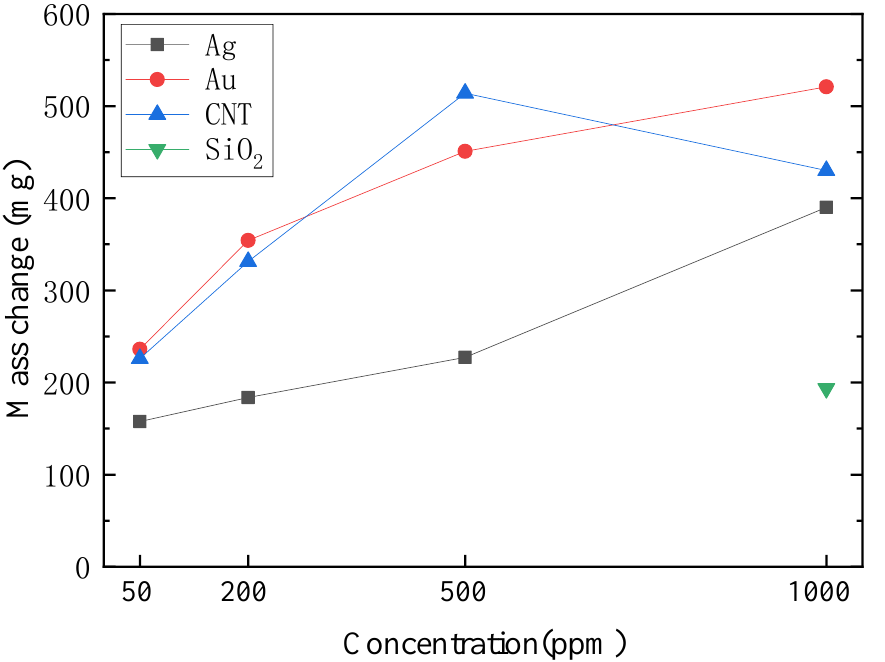
Figure 10. Mass change of different nanofluids in 30 min of illumination.